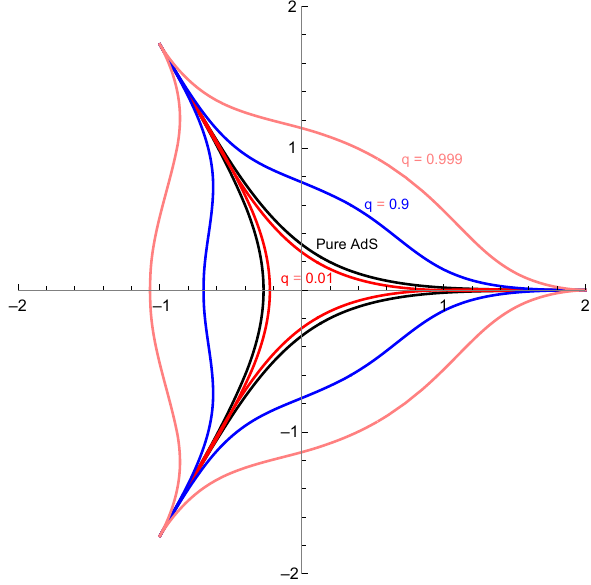
Fig. 2 Spiky D-string which has 3 spikes in AdS space in the presence ofmixedfluxes.OnecanclearlyobservetheslimmingeffectofRRflux, i.e. in the presence of RR flux the fattening occured due to NS-NS flux get reduced. The spike profile for q = 0 . 01 representing mostly due to RR flux is slimmer compared to spike profile in absence of any flux shown by pure AdS profile. Similarly, as depicted above, the